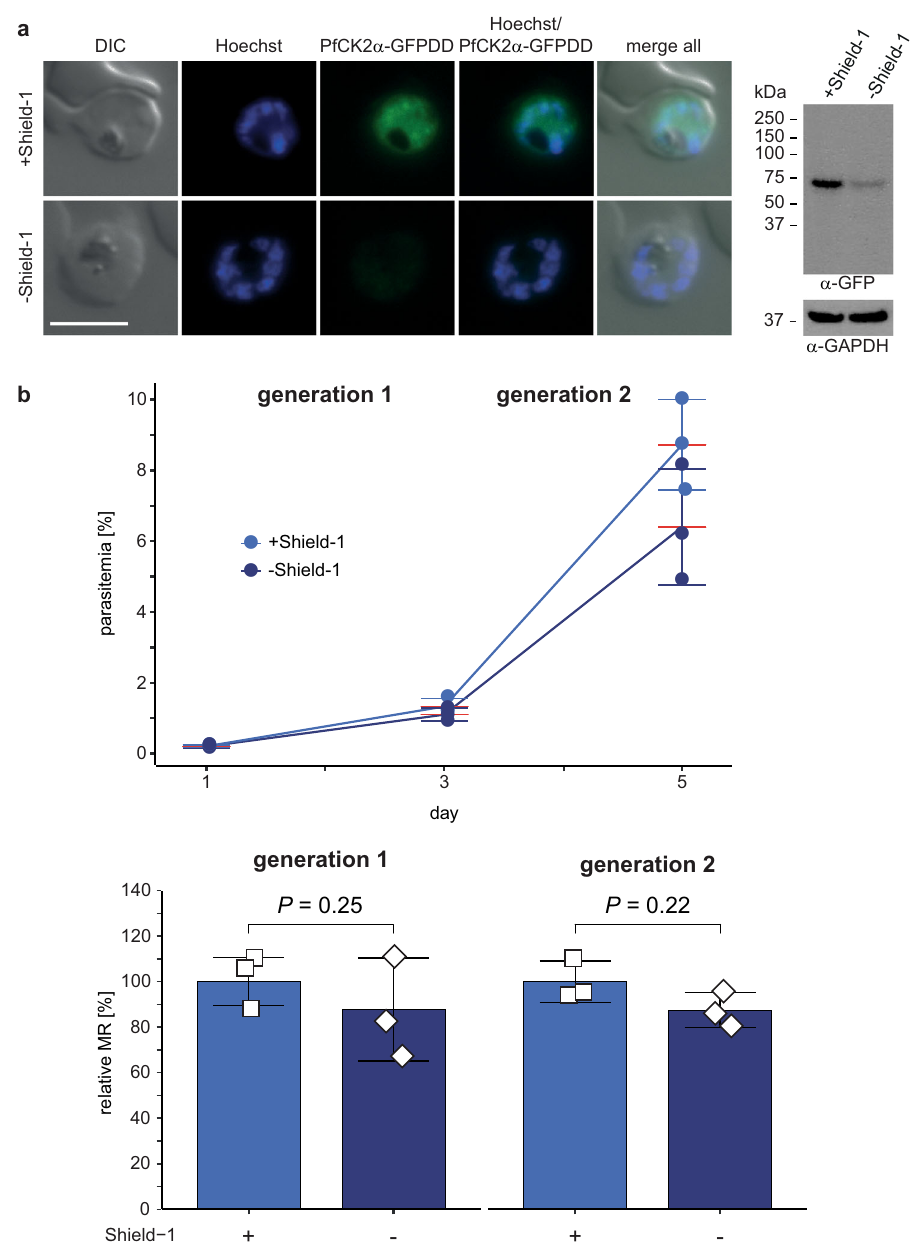
Fig. 2 PfCK2 α depletion in NF54/AP2-G-mScarlet/CK2 α -GFPDD parasites has no effect on asexual parasite multiplication. a Expression of PfCK2 α - GFPDD in schizonts cultured in presence ( + Shield-1) and absence ( − Shield-1) of Shield-1 by live cell fl uorescence imaging and Western blot analysis. Parasites were split (±Shield-1) 40 h before sample collection. Representative images are shown. Nuclei were stained with Hoechst. DIC, differential interference contrast. Scale bar = 5 µ m. For Western blot analysis, protein lysates derived from an equal number of parasites were loaded per lane. MW PfCK2 α -GFPDD = 78.7 kDa, MW loading control PfGAPDH = 36.6 kDa. b Flow cytometry data showing the increase in parasitaemia (top) and parasite multiplication rates (bottom) in two subsequent generations of NF54/AP2-G-mScarlet/CK2 α -GFPDD parasites cultured under protein-degrading ( − Shield-1; dark blue) and protein-stabilizing ( + Shield-1; light blue) conditions. Parasites were split (±Shield-1) at 0 – 6 hpi, 18 h before the fi rst measurement (day 1). The means ±s.d. (error bars) of three biological replicates are shown. Data points for individual replicates are represented by coloured circles (top) or open squares (bottom). Differences in parasite multiplication rates were compared using a paired two-tailed Student ’ s t test ( P values are indicated above the graphs). MR, multiplication